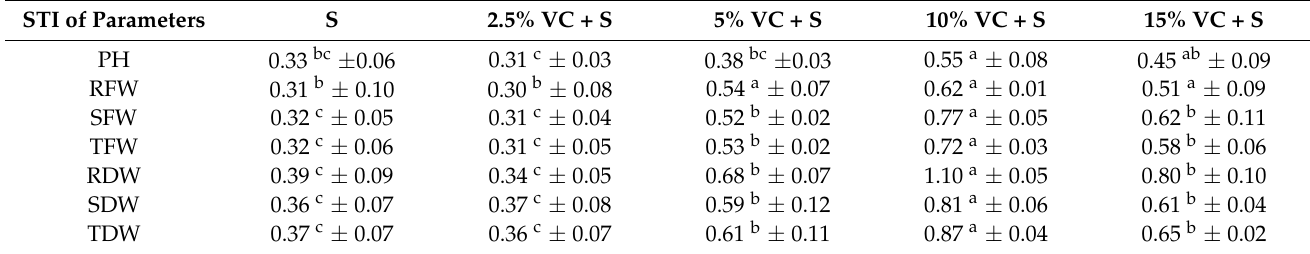
Table 1. Salt tolerance indices (STI) of plant height (PH), root fresh weight (RFW), shoot fresh weight (SFW), total fresh weight (TFW), root dry weight (RDW), shoot dry weight (SDW) and total dry weight (TDW) under 200 mM NaCl (S), 2.5, 5, 10 and 15%VC treatments of Vicia faba plant after 30 days of cultivation. Values are means ± SD based on triplicate independent determinations, and different letters means significant difference as evaluated by Duncan’s multiple comparison test ( p < 0.05).